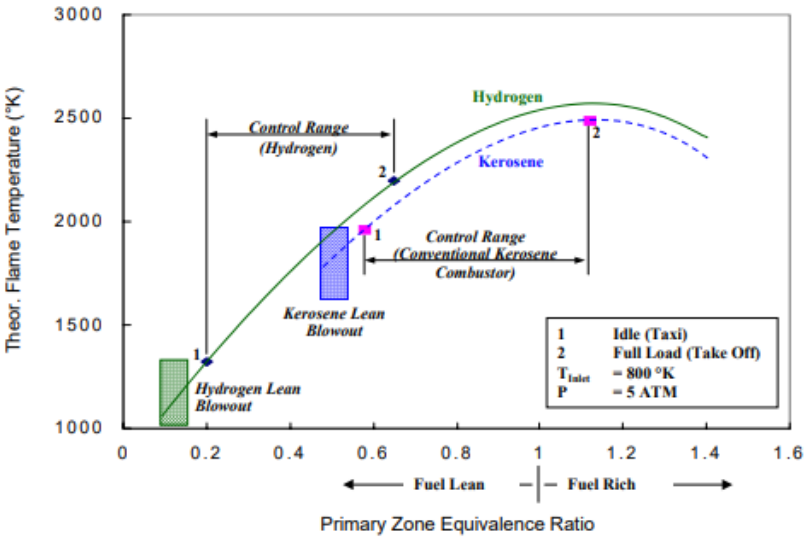
Figure 1. Temperature characteristics of LH 2 and kerosene as a function of the equivalence ratio [6].